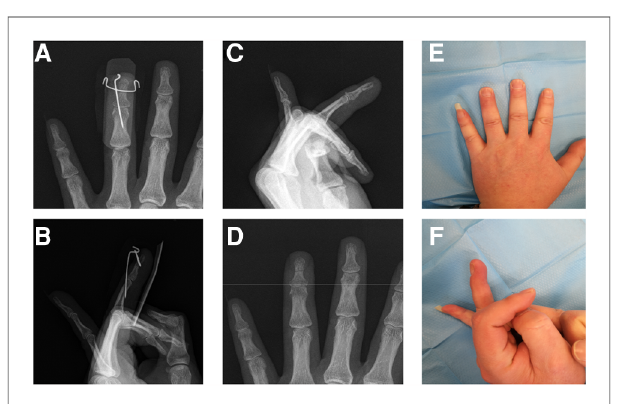
FIGURE 1 A schematic diagram of the new technique (1. Blocking wire; 2. K -wire; 3. Rubber band; 4. Hook; 5. Hook; 6. Avulsion fracture; 7. Middle phalanx; 8. Distal phalanx).